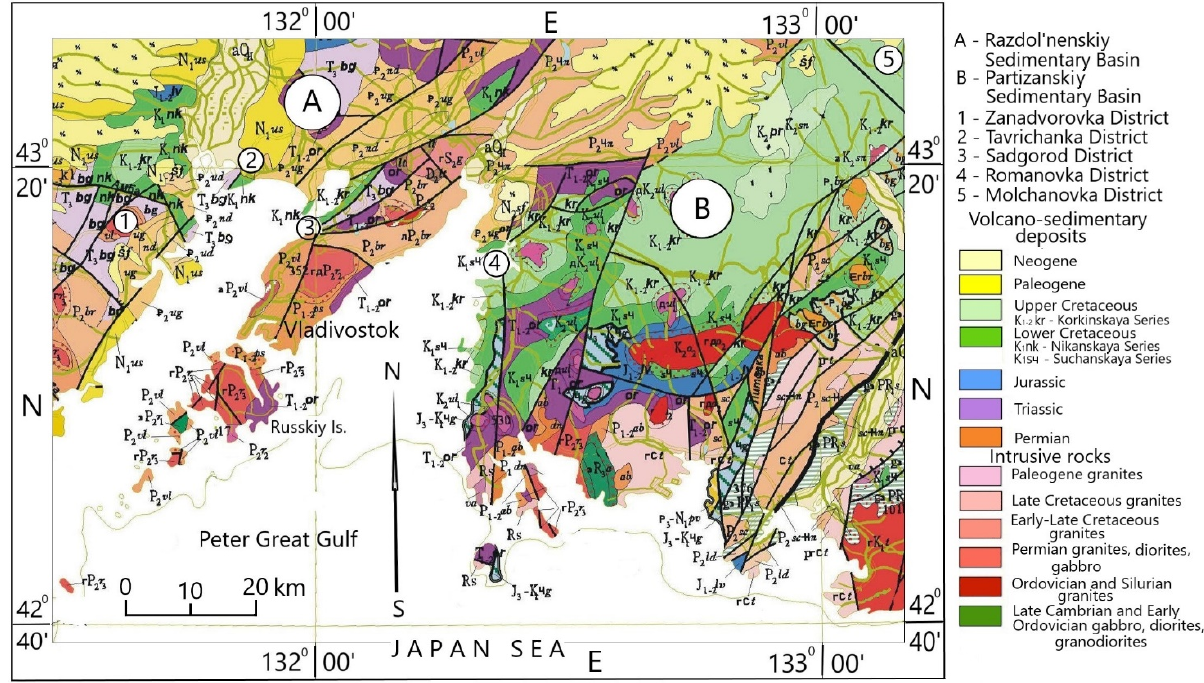
Figure 1. Geological map of the study area (Southern Primorye, Russia) [30]. The basement of the Partisanskiy Sedimentary Basin is composed of a complex of Early Paleozoic gabbroid and granitoid from the Sergeevskiy Terrane, overlaid by Late